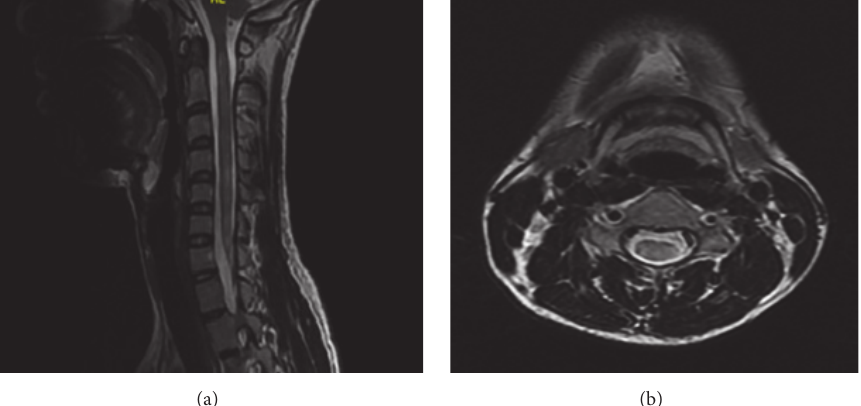
Figure 4: Sagittal (a) and axial (b) T2 weighted images of LESCLs with cord oedema in a patient with negative anti-AQP4